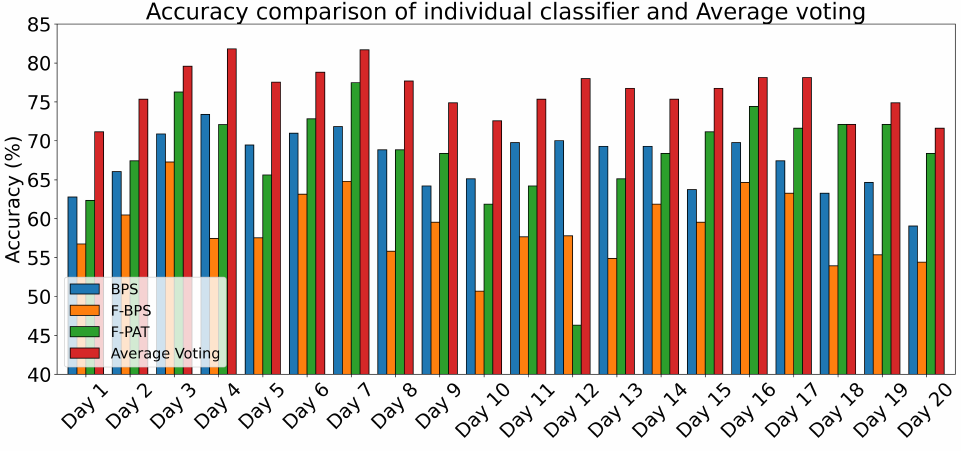
Figure 10. Accuracy in % of the individual classifiers and the average voting